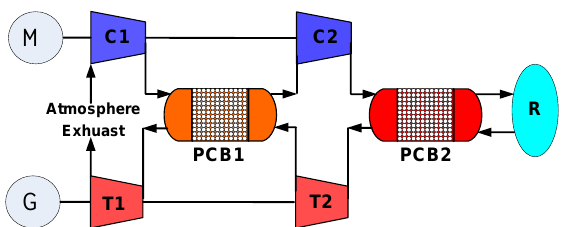
Figure 8. Schematic diagram of AA-CAES system with PCB units (C—Compressor, T—Turbine, G—Generator, M—Motor, R—Reservoir) [34].